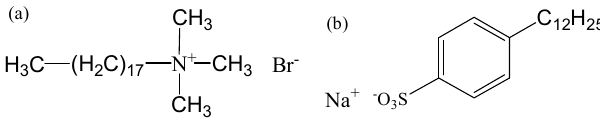
Figure 1. Molecular structure formula of emulsifier ( a ) Stearyl trimethyl ammonium bromide ( b ) Figure1. Molecularstructureformulaofemulsifier( a )Stearyltrimethylammoniumbromide( b )Sodium Sodium dodecyl benzene sulfonate. dodecyl benzene sulfonate.